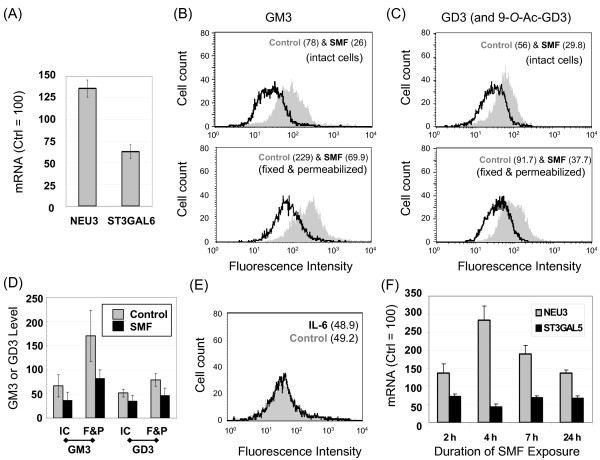
Effects of SMF on gangliosides GM3 and GD3 and IL-6. (A) mRNA levels increased for NEU3 and decreased for ST3GAL3 during the first 24 hours of SMF exposure consistent with a flow cytometry-measured reduction in GM3 (Panel B) and GD3/9-O-AcGD3 levels (the antibody used recognized both the 9-O-acetylated and hydroxyl forms of GD3, Panel C). (D) Data from three independent flow cytometry experiments are summarized; GM3 or GD3 levels are given as measured in the arbitrary units shown on the x-axis of Panels B and C. (E) IL-6, which led to a decrease in ganglioside levels in naïve cells (see Figure 6A) had no further effect on GM3 levels (or GD3 levels, not shown) in SMF-treated cells. (F) A time course of NEU3 and ST3GAL5 shows up- or down-regulation, respectively, over time points shorter than 24 h. Error bars for Panels A, D, and F represent SD for n ≥ 3 independent experiments and p < 0.05 for all data points that compare SMF-treated samples with the matched untreated controls.